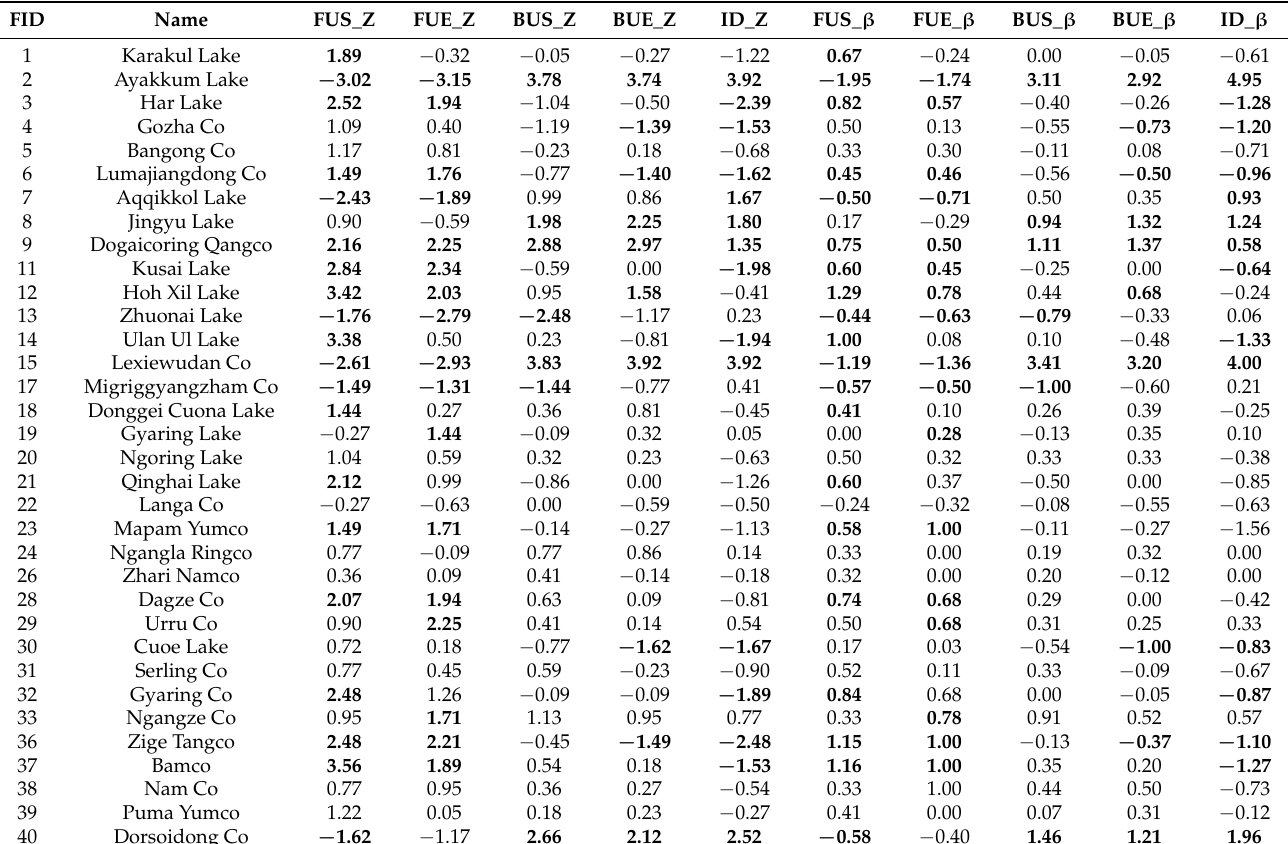
Figure 3. Break-up end date changes in Qinghai Lake during 2002–2021. Table 5. Mann–Kendall trend analysis results of lake ice phenological parameters from 2002 to 2018. The black bold numbers represent the statistical significance at the 0.1 level (Mann–Kendall test).